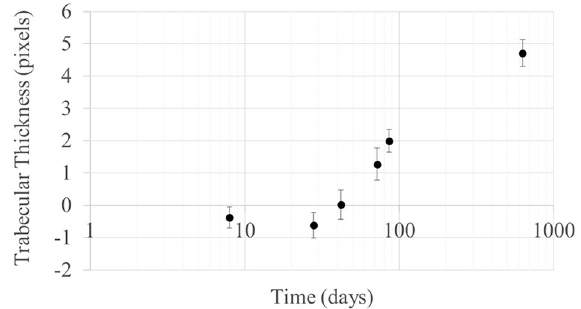
Figure 3. Normalized trabecular thickness Tb.Th(callus)-Tb.Th(healthy) per sample. Graph realized with Microsoft Excel.